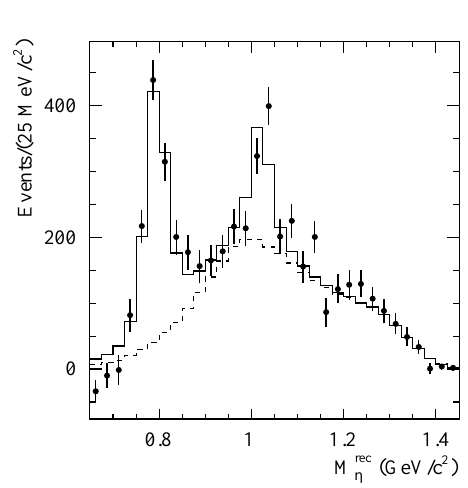
Figure 1. The M η spectrum for selected data events (points with error bars). The solid histogram is the re- sult of the fit to the data spectrum with a sum of signal and background distributions. The fitted background contribution is shown by the dashed histogram.